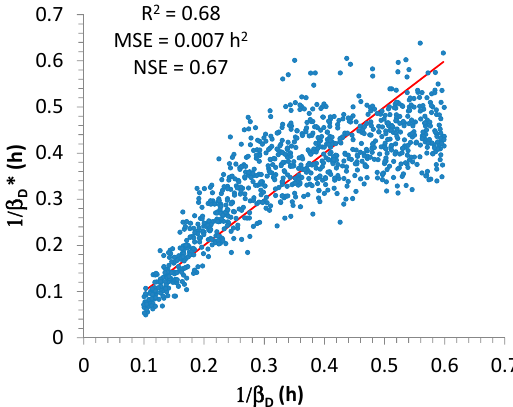
β and the various β I and the various I